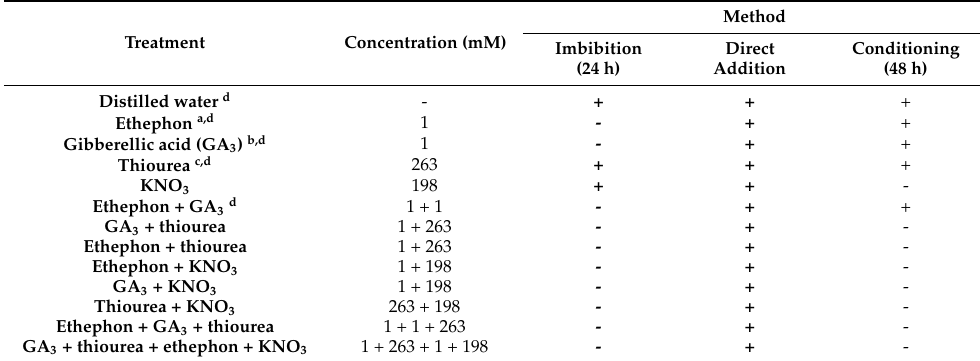
Table 3. Treatments that were applied to freshly collected or cold-stored Ambrosia artemisiifolia seeds in the laboratory and the